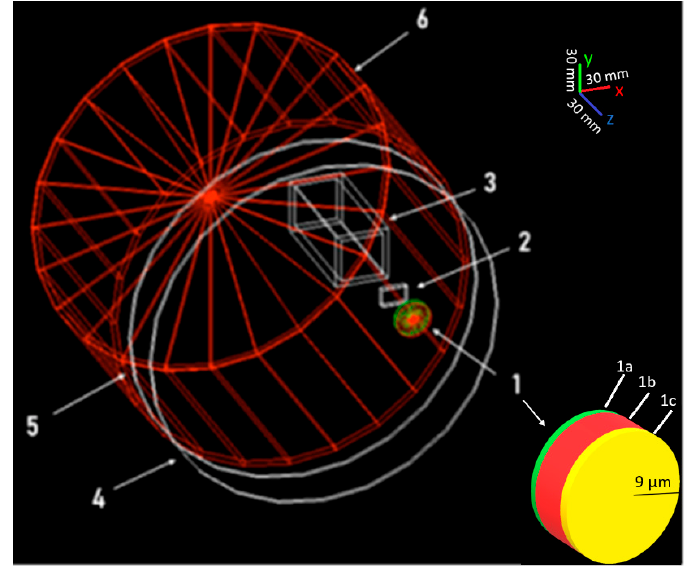
Figure 1. Geometry mesh of the GEANT4 simulation model: 1a—source of electrons; 1b—target; 1c—source of protons; 2—hole; 3—magnetic spectrometer; 4—target holder; 5—detector holder; 6—aluminum cylinder. The structure of the electron, proton sources and target are presented in the right corner of the image.